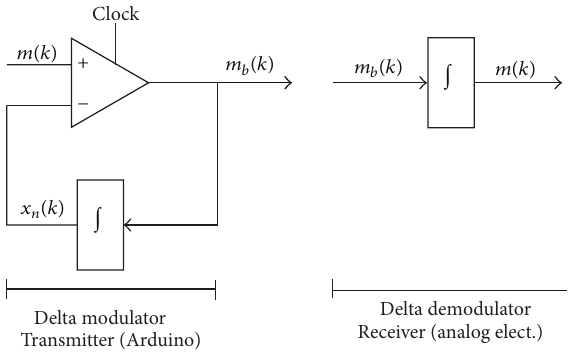
Figure 6: Diagram of the simple Delta modulator.